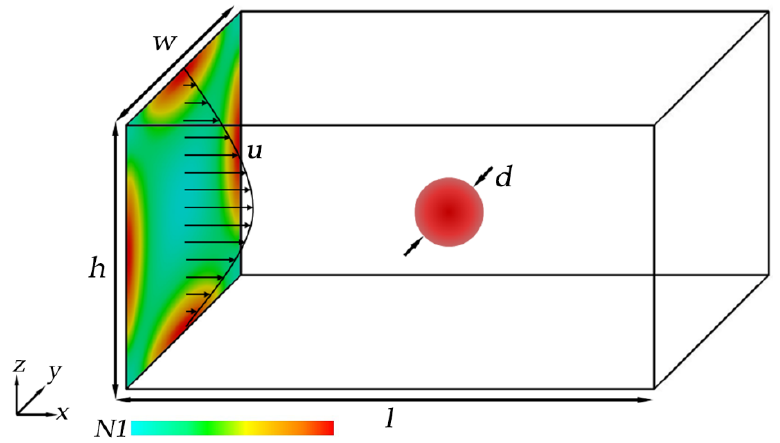
Figure 1. Schematic diagram of the 3D channel model. Micromachines 2020 , 11 , x FOR PEER REVIEW